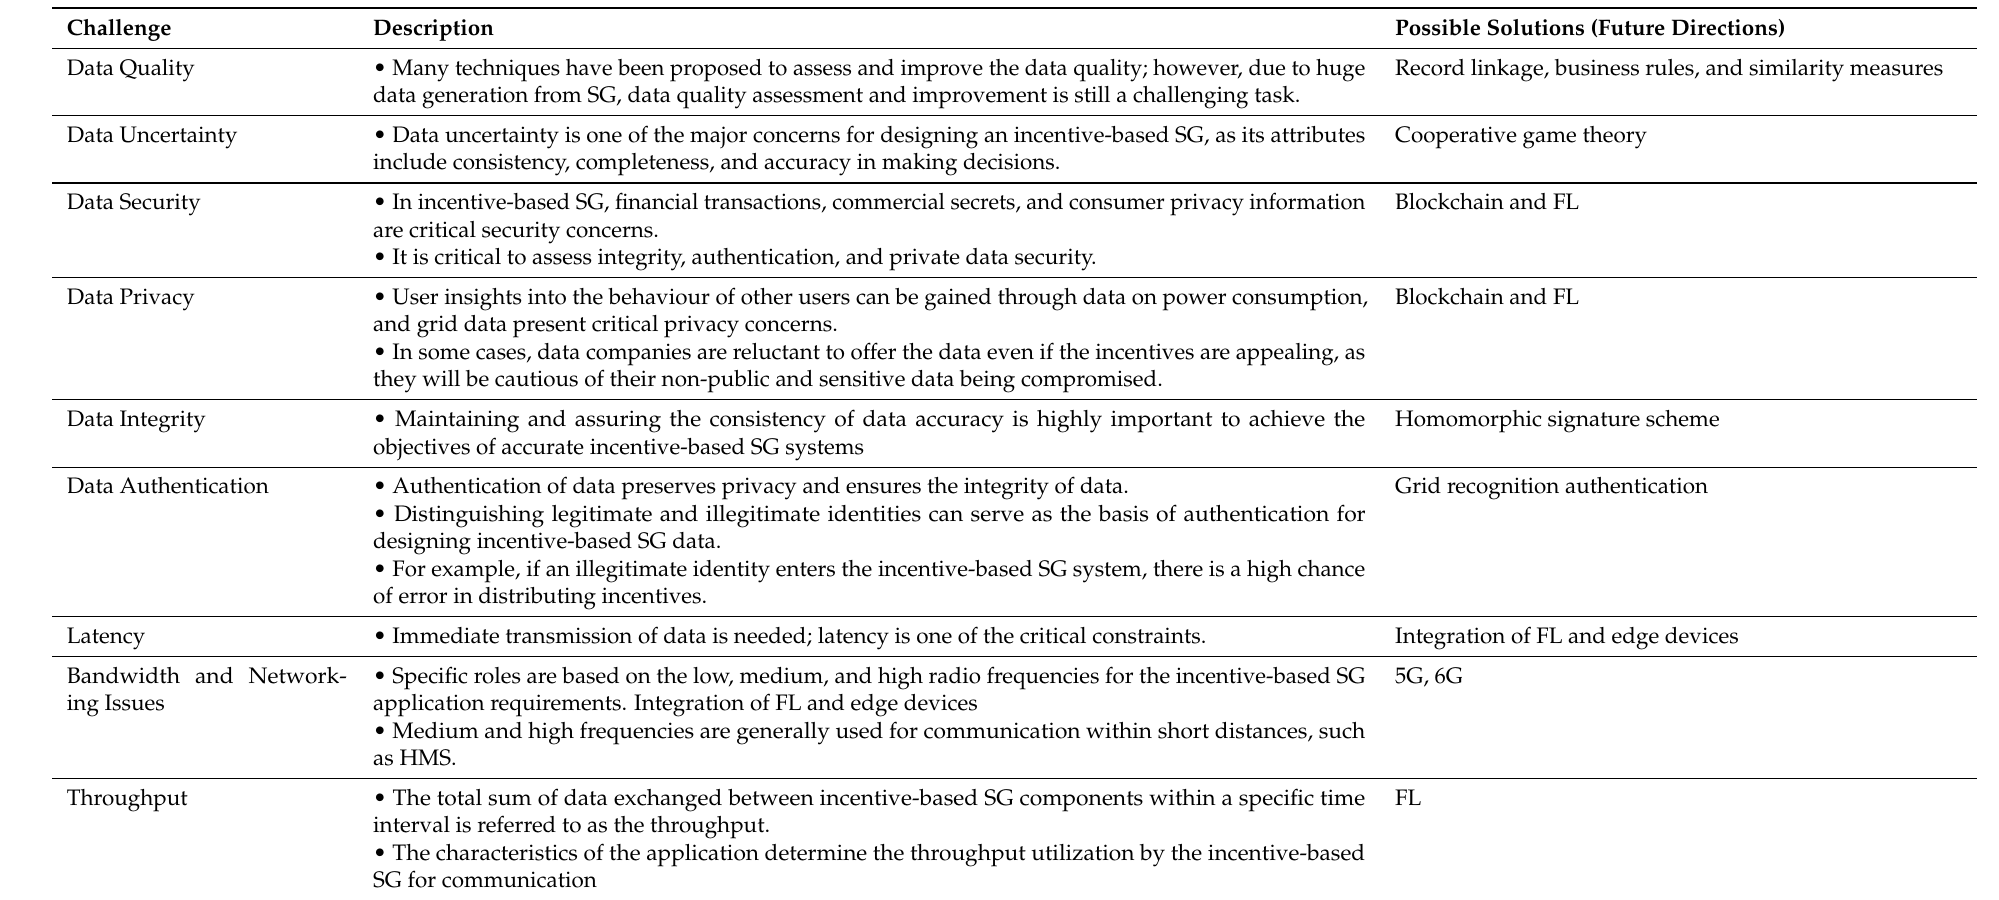
Table 5. Challenges for Incentive-based SG and Possible